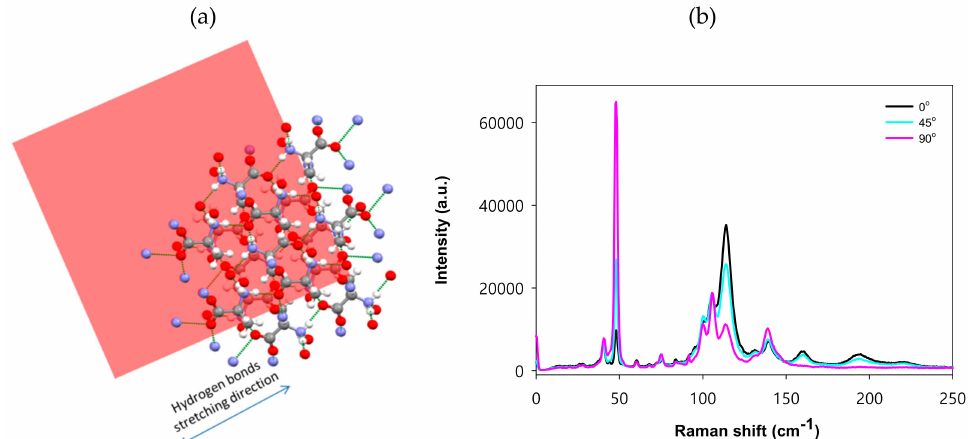
Figure 3. ( a ) Simulation of hydrogen bonds (dotted lines) in the L-alanine single crystal relative to the (002) plane. ( b ) LF-Raman spectra of the crystal excited from the (002) plane in three beam polarization directions: zero (black), 45 (cyan), and 90 (pink)